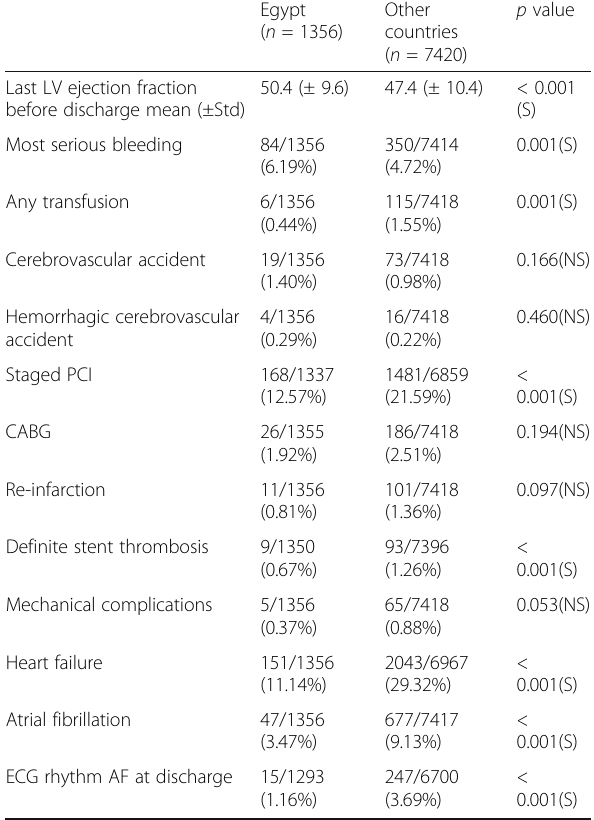
Table 3 Patients course during hospitalization; Egypt vs. other